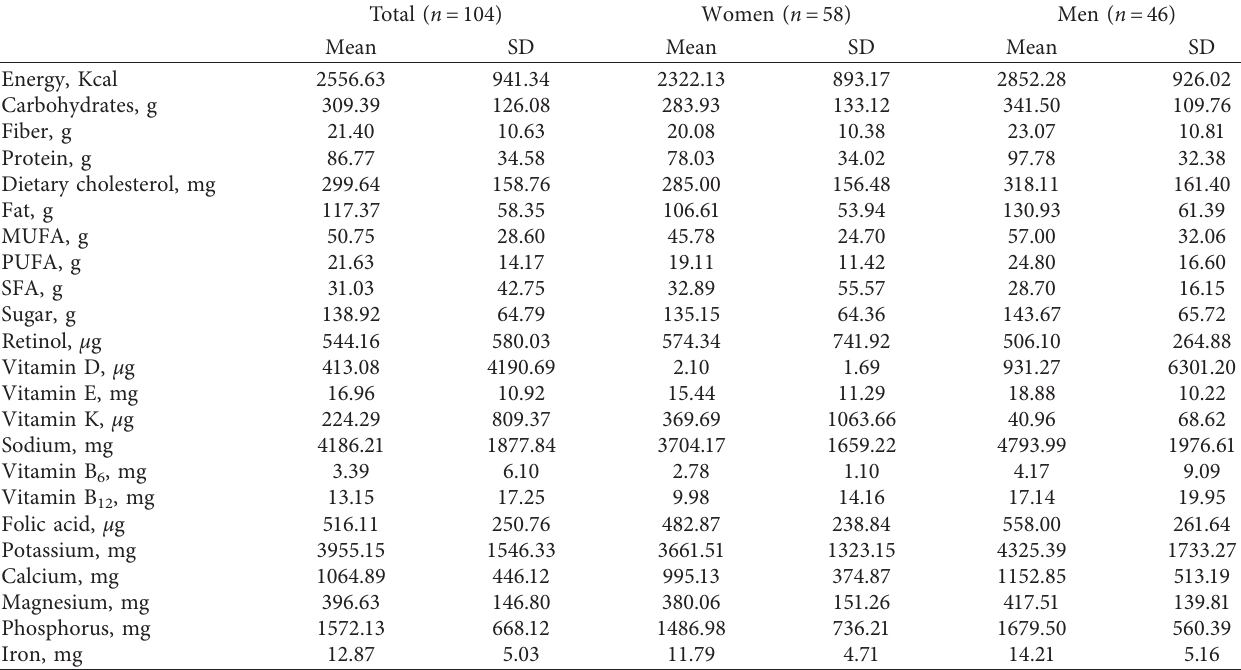
Table 2: Dietary intake of the study sample.